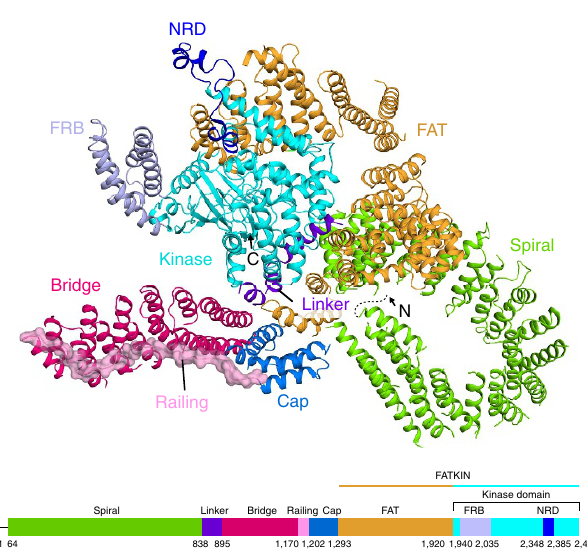
Figure 1 | Fold of the KmTor monomer. The ribbon diagram of the KmTor monomer is illustrated above a bar showing the domain organisation of KmTor. Domain coloring of the bar matches the coloring of the ribbons. The dashed line (on the model) and a straight line (at the beginning of the bar showing the domain organization) indicate a portion of the KmTor N-terminus that is not present in the cryo-EM